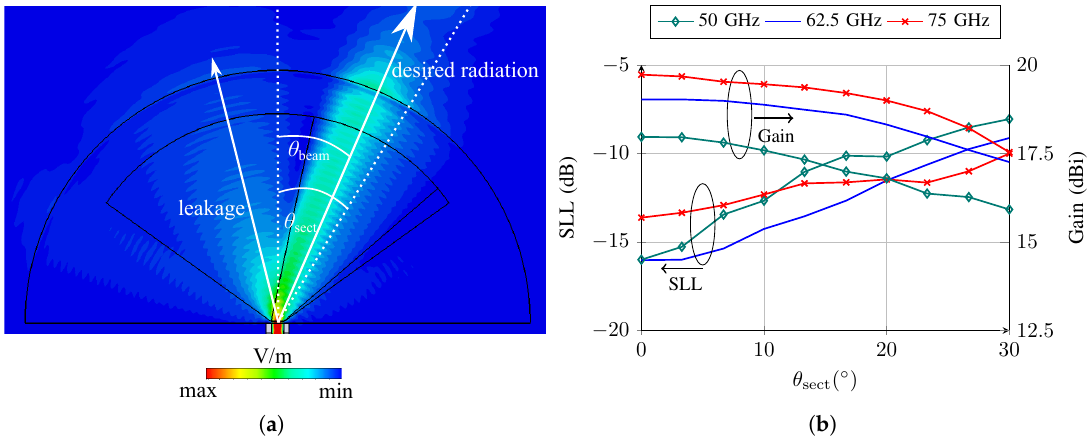
Figure 41. ( a ) Full wave simulation of the parallel-plate lateral wave antenna in a steered configuration at 62.5GHz, ( b ) simulated gain and SLL in dependency of θ sect at three selected frequencies in